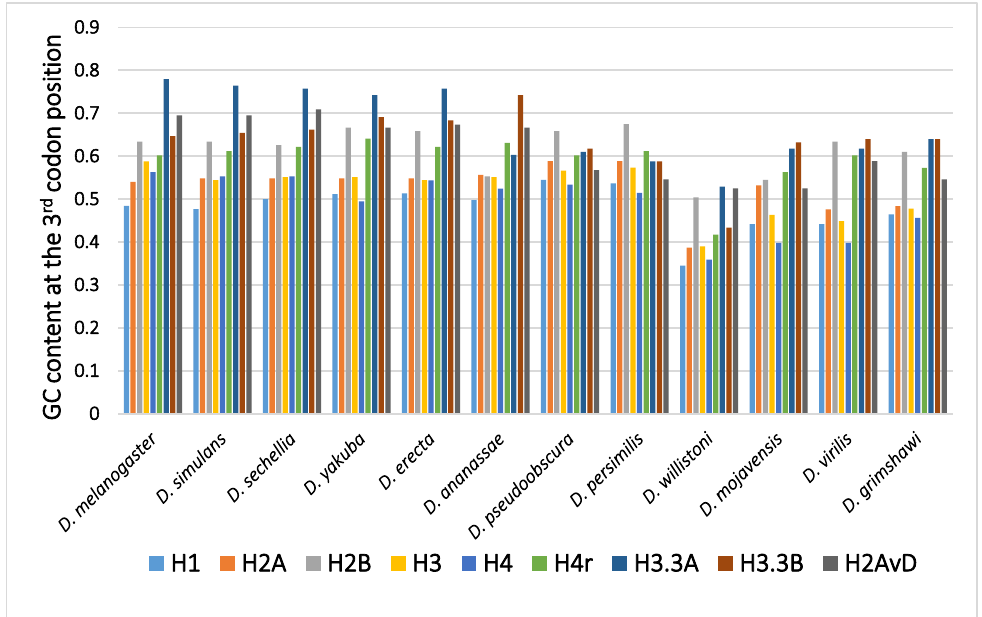
Figure 1. The GC content at the third codon position of the histone genes in Drosophila . The data grouped according to the Drosophila species.